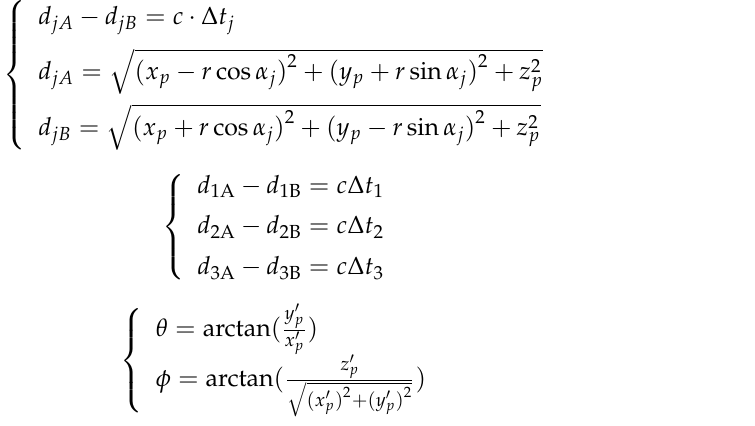
Figure 1. The direction measurement method for one partial discharge (PD) source based on two directional antennas.